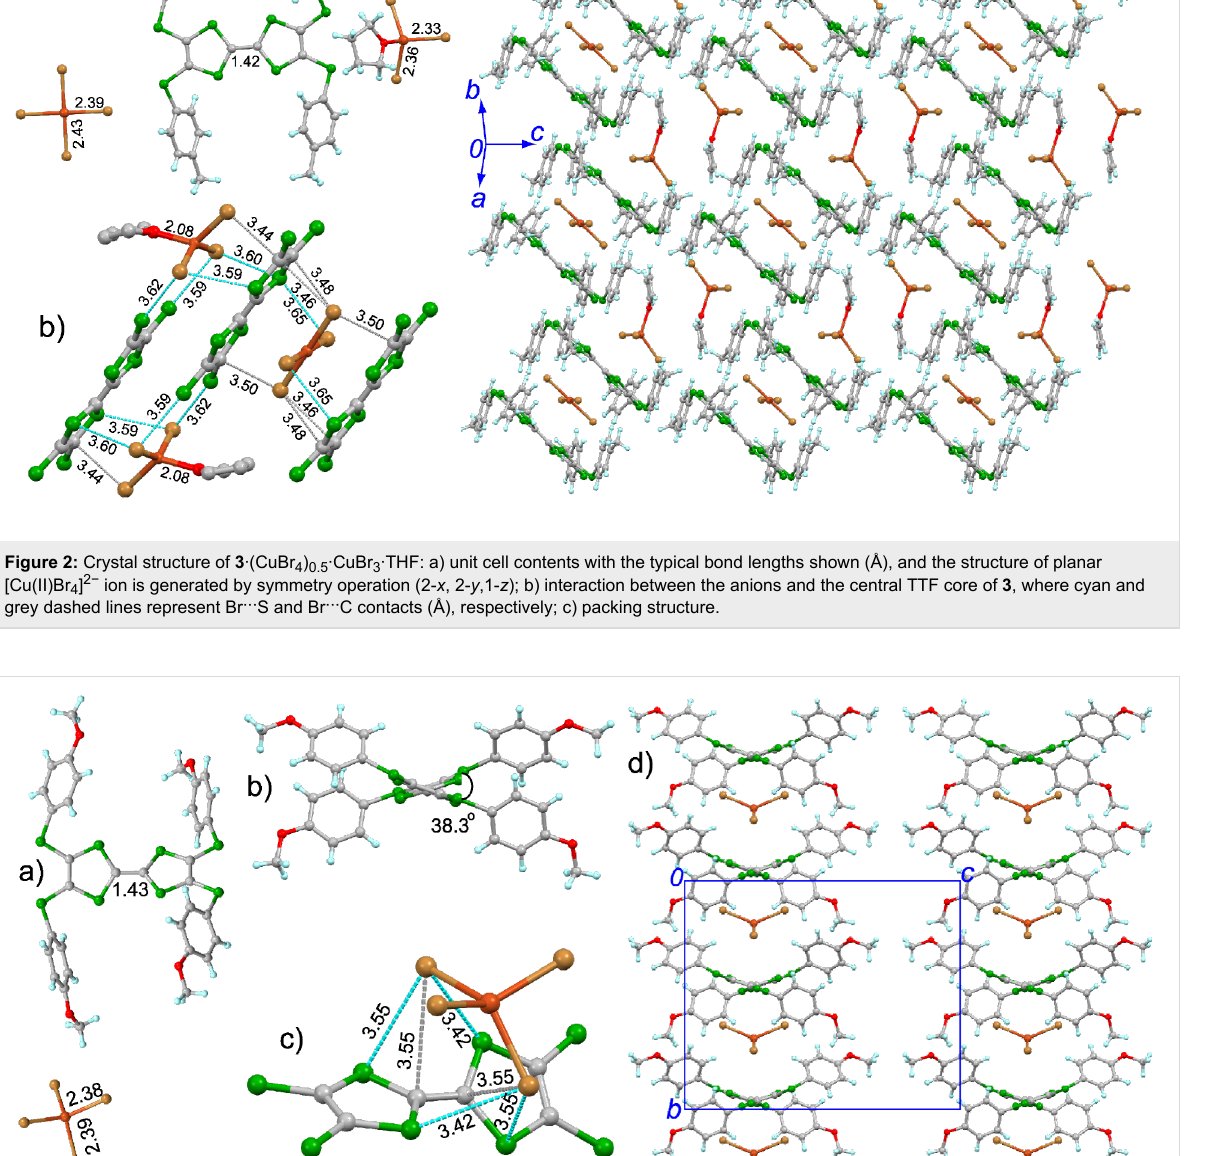
dihedral angle of 38.3° as shown in Figure 3b. The CuBr 4 component shows the tetrahedral conformation with a Cu–Br bond length of 2.38 and 2.39 Å, thus CuBr 4 is a dianion. The [CuBr 4 ] 2 − ion locates above the donor molecule, and there are Br ··· S (3.42–3.55 Å) and Br ··· C contacts (3.55 Å) between the [CuBr 4 ] 2 − ion and 4 as shown in Figure 3c. Molecule 4 and the